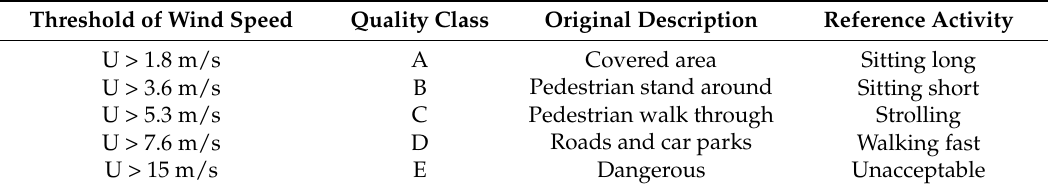
Table 5. Wind speed classification based on pedestrian comfort, after